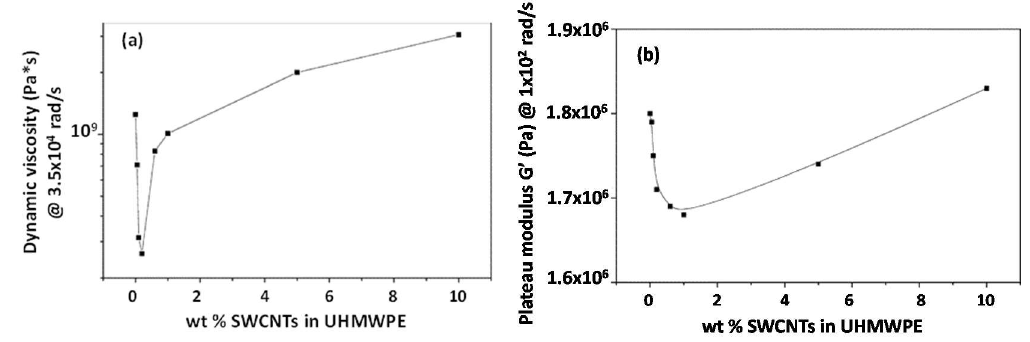
Figure 3. Variation of ( a ) dynamic viscosity and ( b ) plateau modulus as a function of nanotube content in ultra-high-molecular-weight polyethylene (UHMWPE)/single-walled carbon nanotubes (SWCNT) nanocomposites. Reprinted with permission from [58]. Copyright (2006) American Chemical Society.